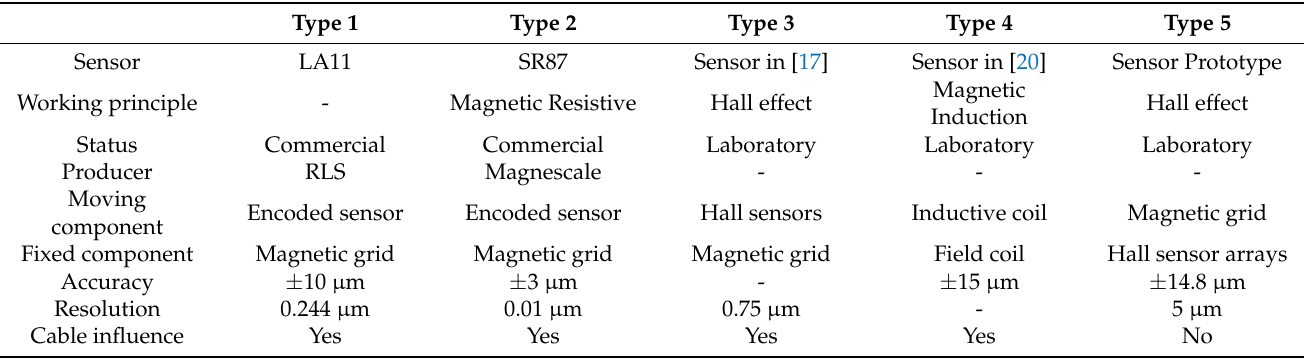
Table 3. Comparison with different types of magnetic absolute linear sensors.